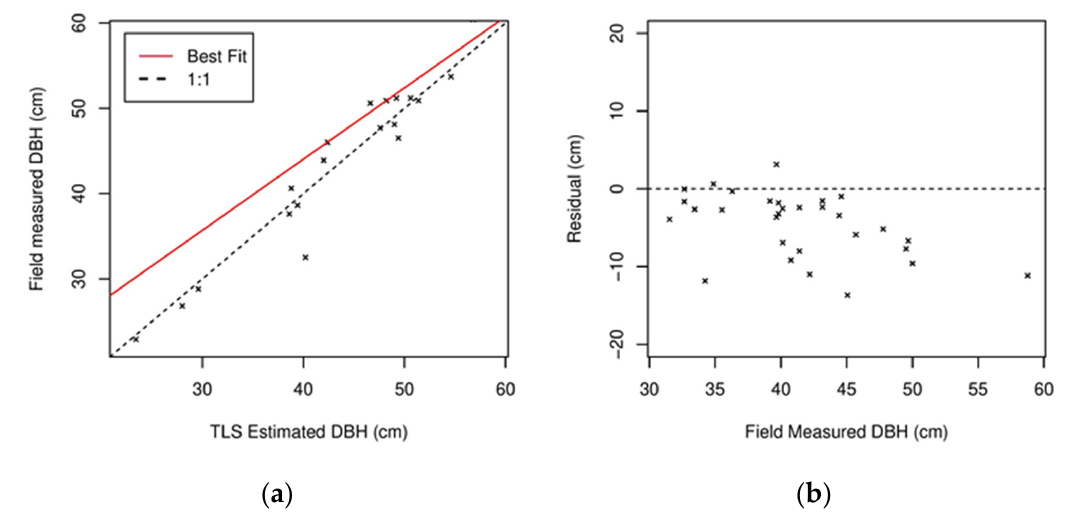
Figure 18. Forest stand measurements: ( a ) DBH comparison between TLS to field measurements (tape measure). ( b ) Regression plots for DBH from TLS residuals for the estimated DBH.